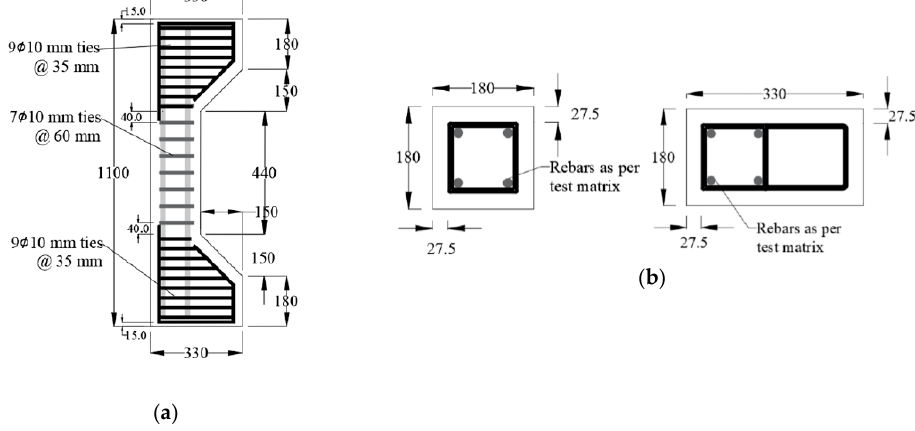
Figure 8. Experimental columns and cross-sections (in mm) by ElMessalami [32]: ( a ) Column dimensional details; ( b ) Column Cross Section.